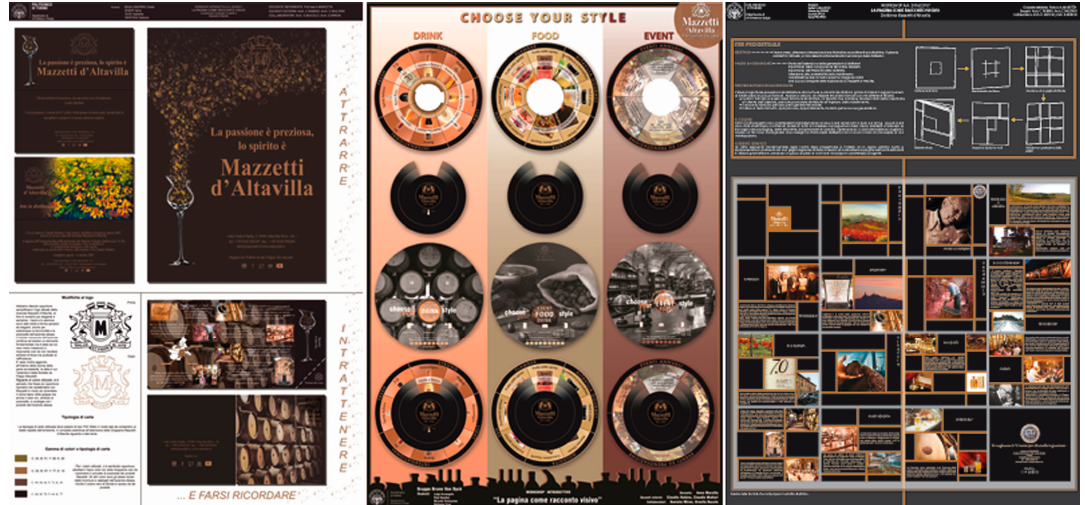
Figure 3. Three of the four promotional display panels of Distilleria Mazzetti d’Altavilla.